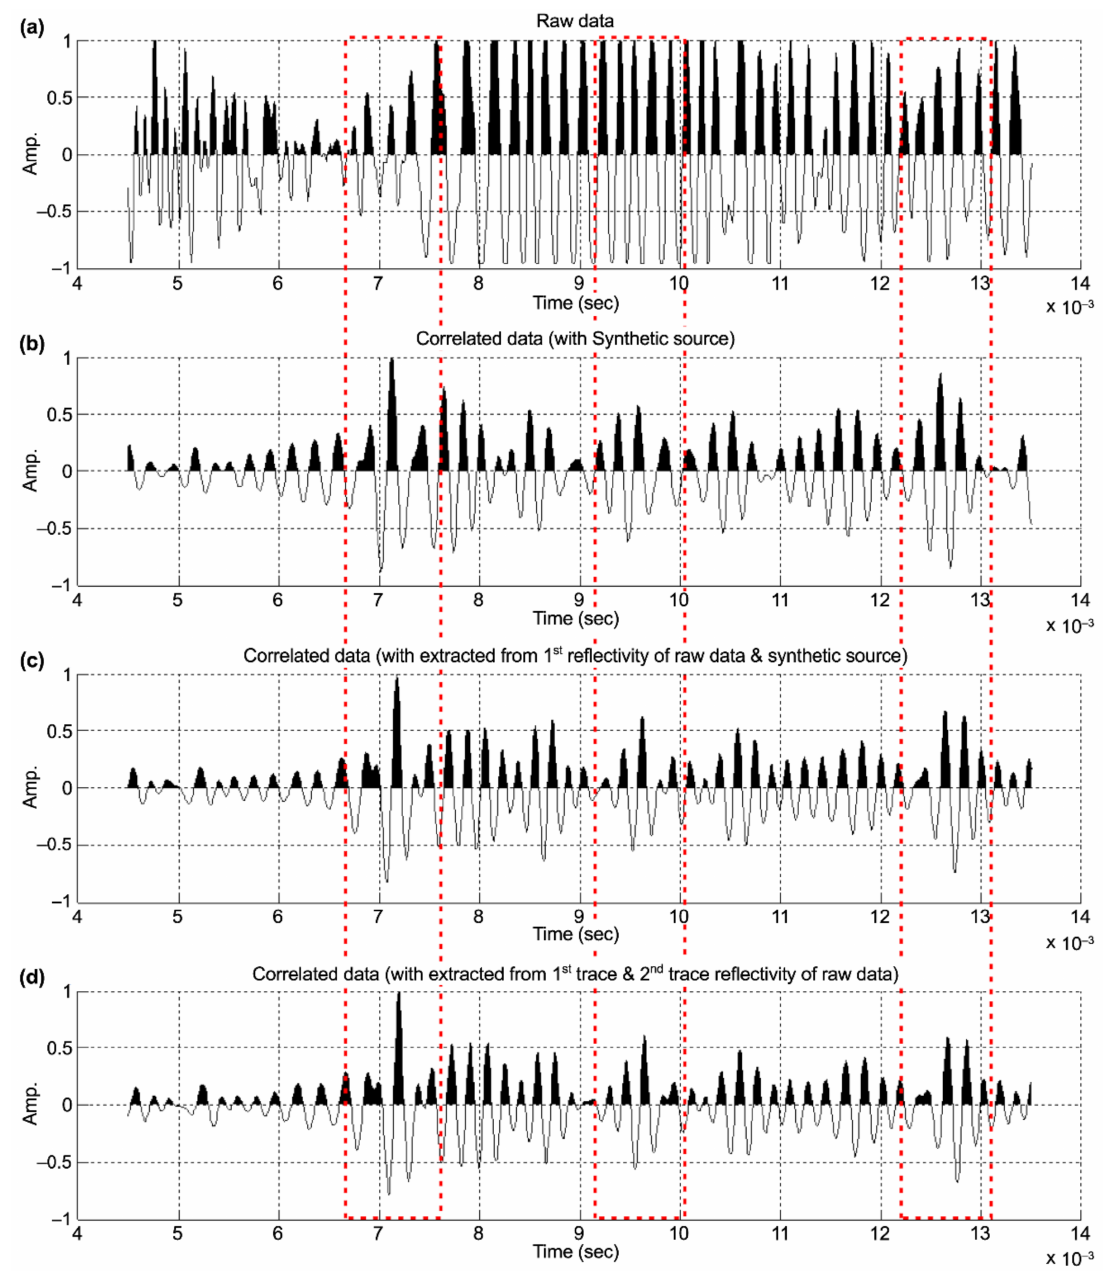
Figure 10. Comparison of Klauder wavelets. ( a ) Raw data 1, ( b ) correlated with 2–7 kHz ideal Chirp wavelet (Source I), ( c ) correlated with Source II, and ( d ) correlated with Source